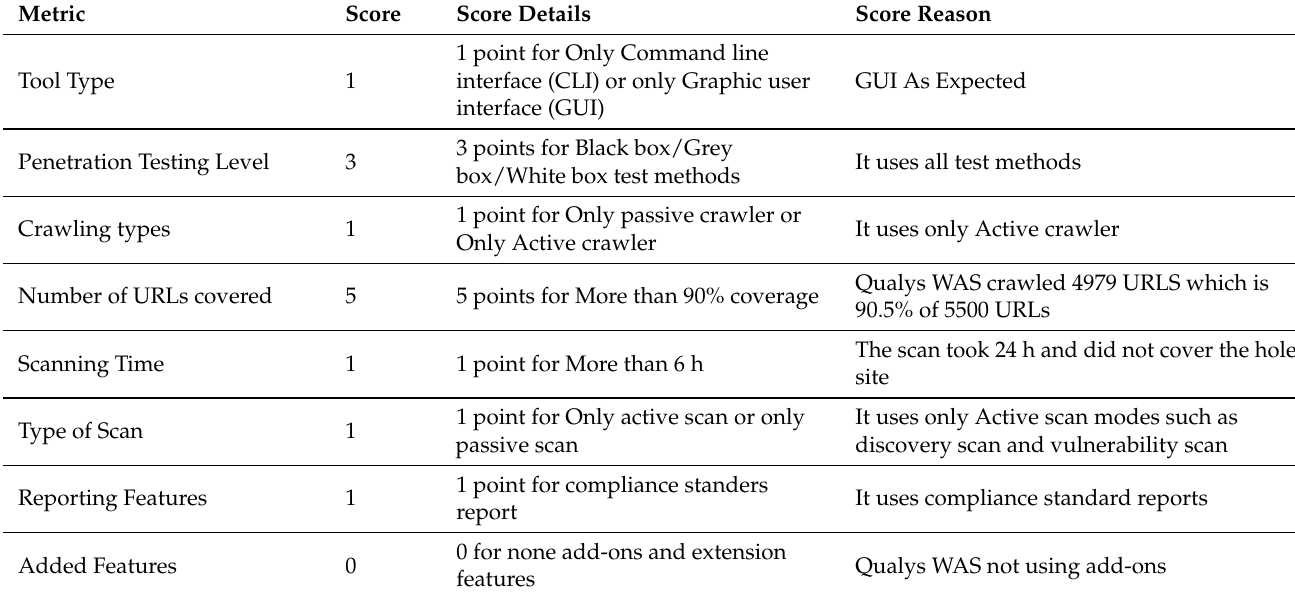
Table A3. Results of benchmarking Qualys WAS using our framework in